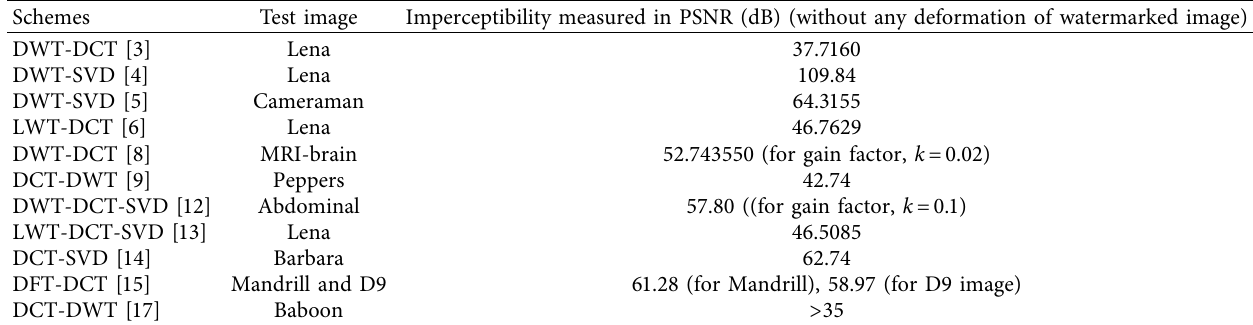
Table 2: Evaluation performance of the watermarked